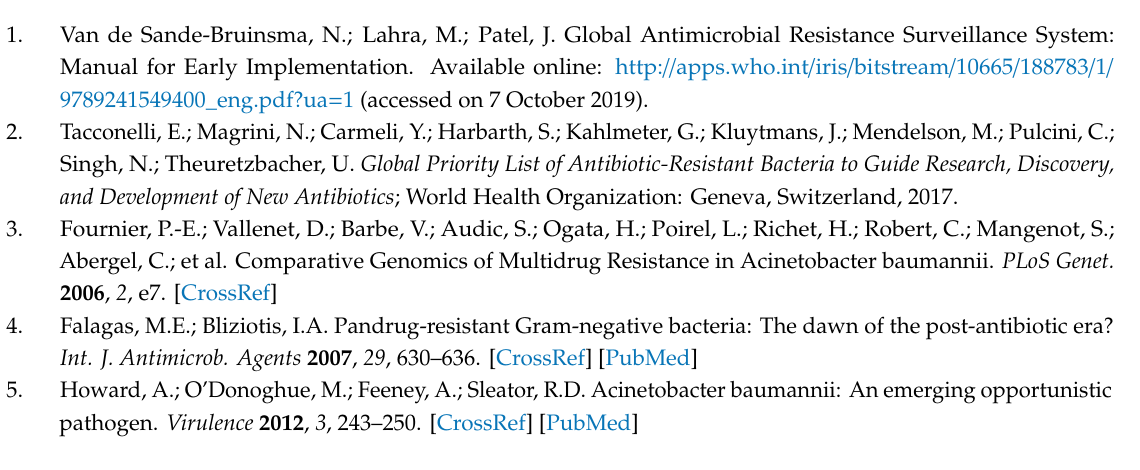
Figure S1 : Morphology of plaques formed by bacteriophages on a lawn of Acinetobacter baumannii . Figure S2 : Transmission Electron Micrographs of A. baumannii bacteriophages. Table S1 : Details on clinical sources of Acinetobacter baumannii host strains. Figure S3a–e : Eight-hour growth curve for Acinetobacter baumannii strains grown with bacteriophages added at di ff erent multiplicity of infections (MOIs). Table S2 : Logarithmic titer of bacteriophage vPhT2 after storage for 30 days in di ff erent temperature and light conditions. Table S3 : Minimum inhibitory concentrations (MICs) of antibiotics against Acinetobacter baumannii host strains. Figure S4 : Photo of drop test screen for zones of inhibition caused by a range of antibiotics against Acinetobacter baumannii strains. Supplement File :